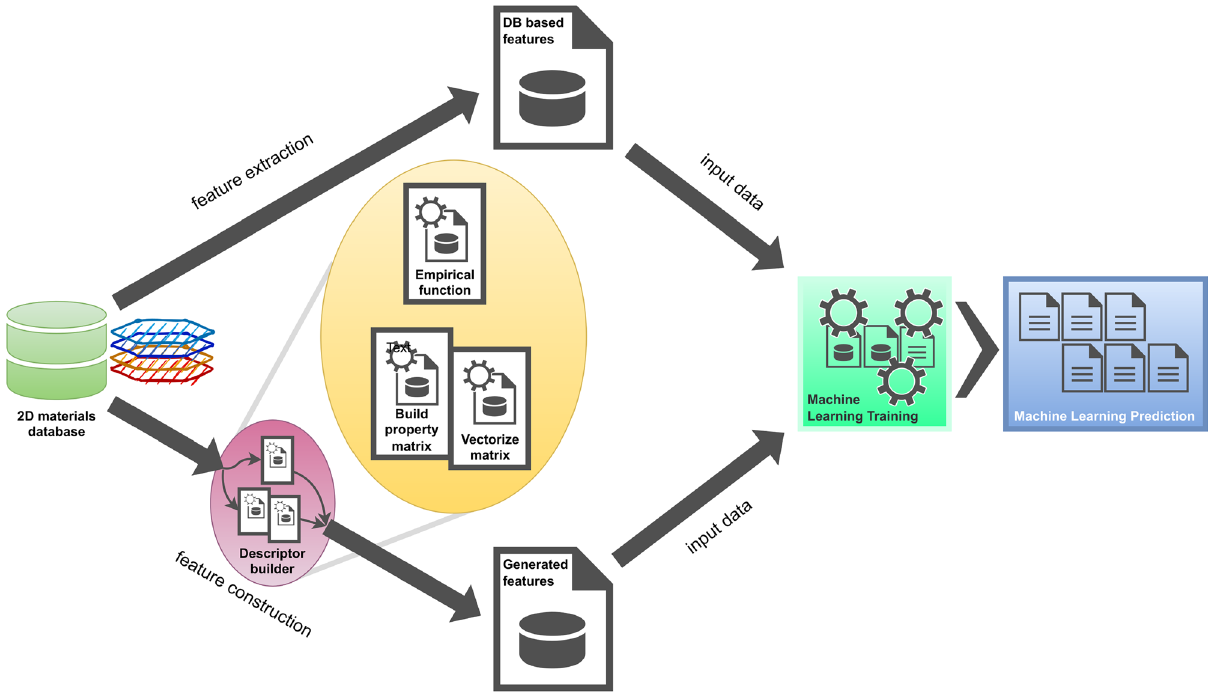
Figure 1. Workflow of the concept of hybrid descriptor engineering: C2DB database feeds the descriptor processing that produces input features for ML training and prediction. The generated features are mixed features from vectorized property matrices and empirical function